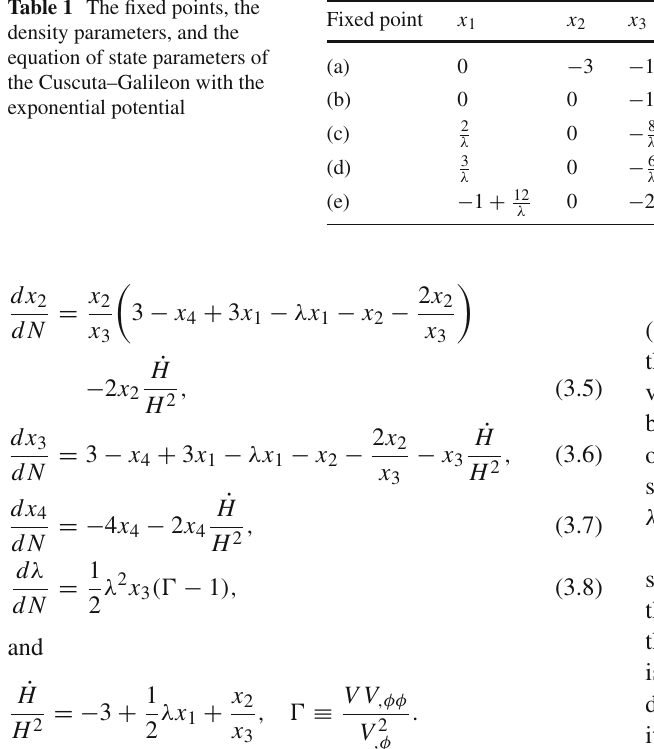
Table 1 The fixed points, the density parameters, and the equation of state parameters of the Cuscuta–Galileon with the exponential